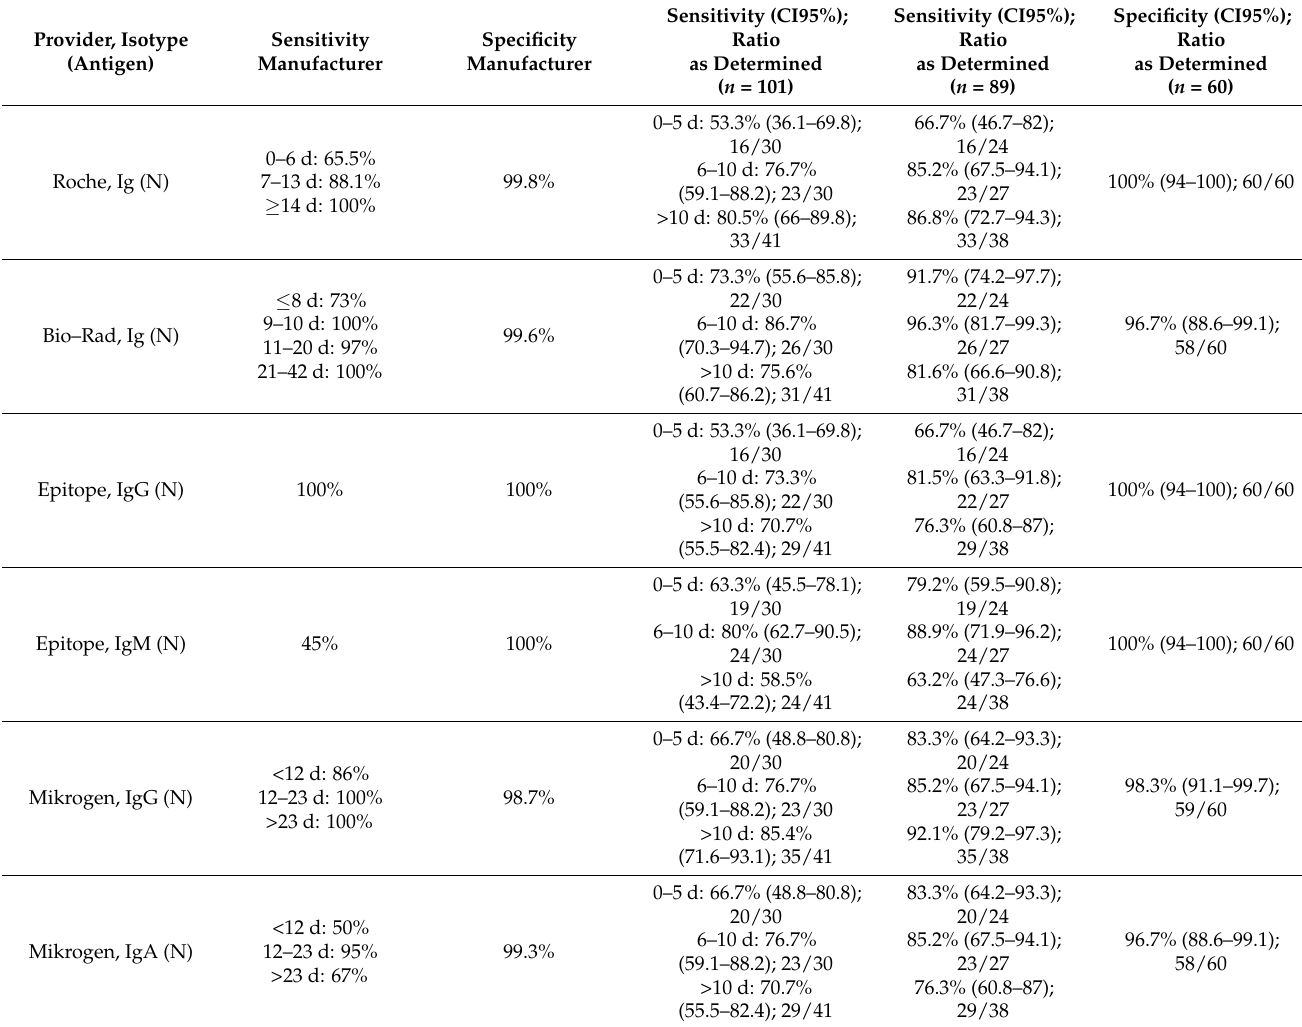
Table 2. Specificity and sensitivity of the evaluated